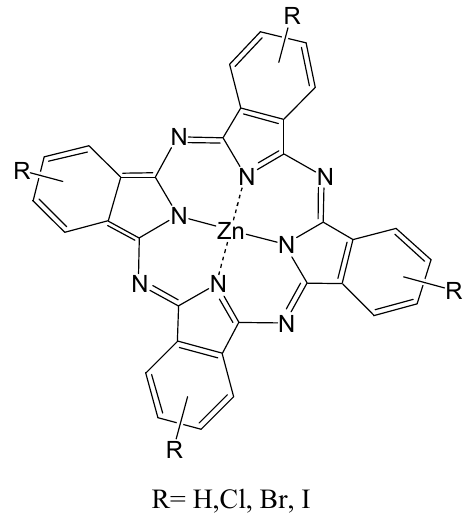
Figure 15. Eosin and dibromorhodamine structures containing heavy atoms.